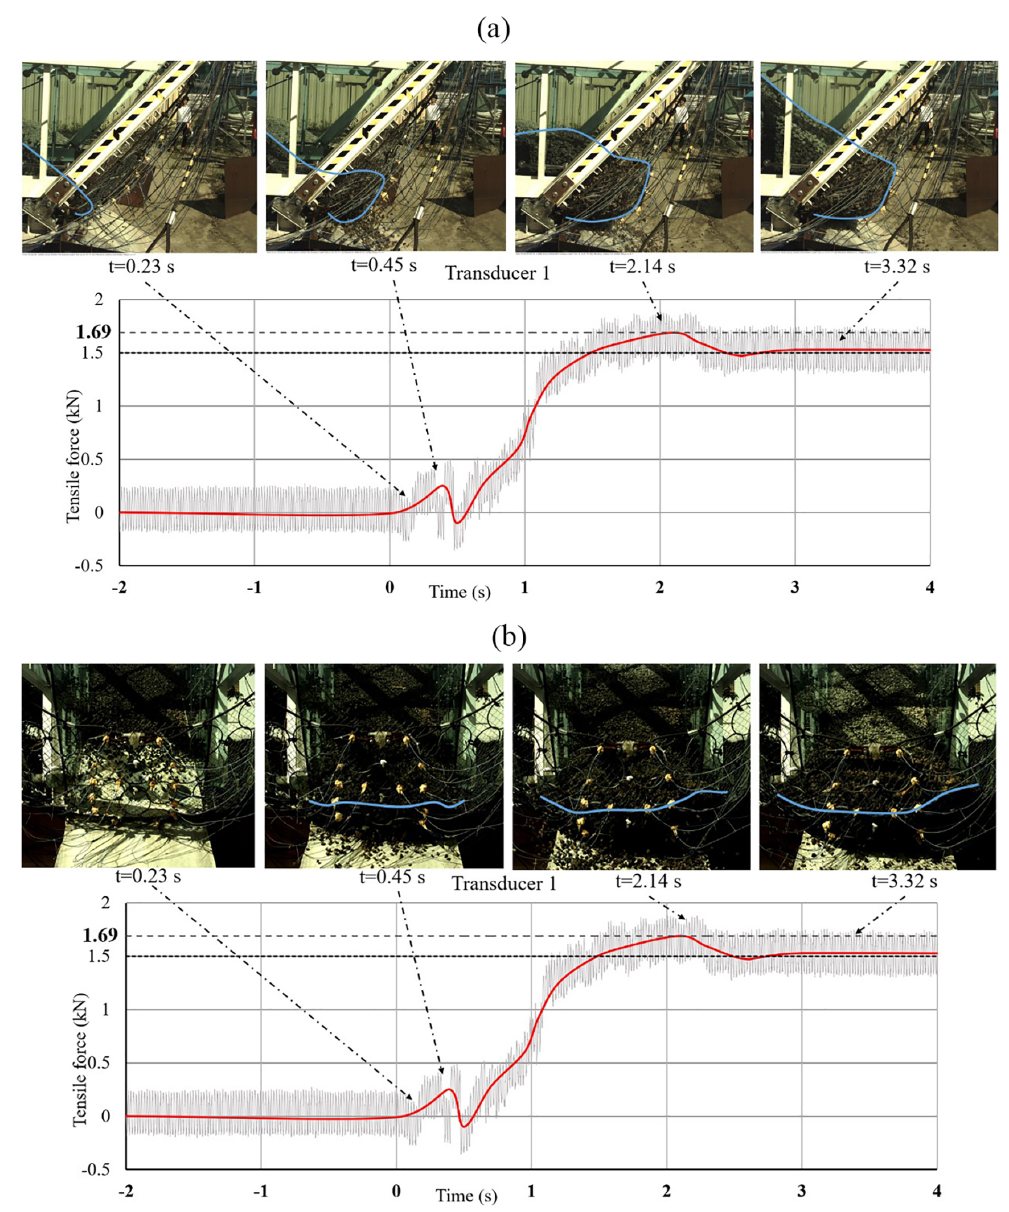
Figure 8. Interpretation of the typical video frames in test 1 recorded by (a) the side-view camera and (b) the front-view camera with the data of tensile force from transducer